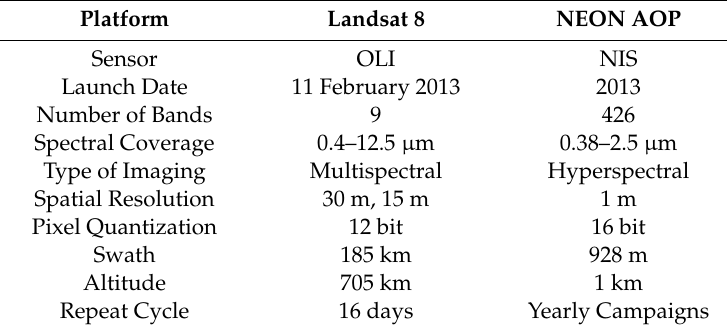
Table 1. Comparison of OLI and NIS Sensors.